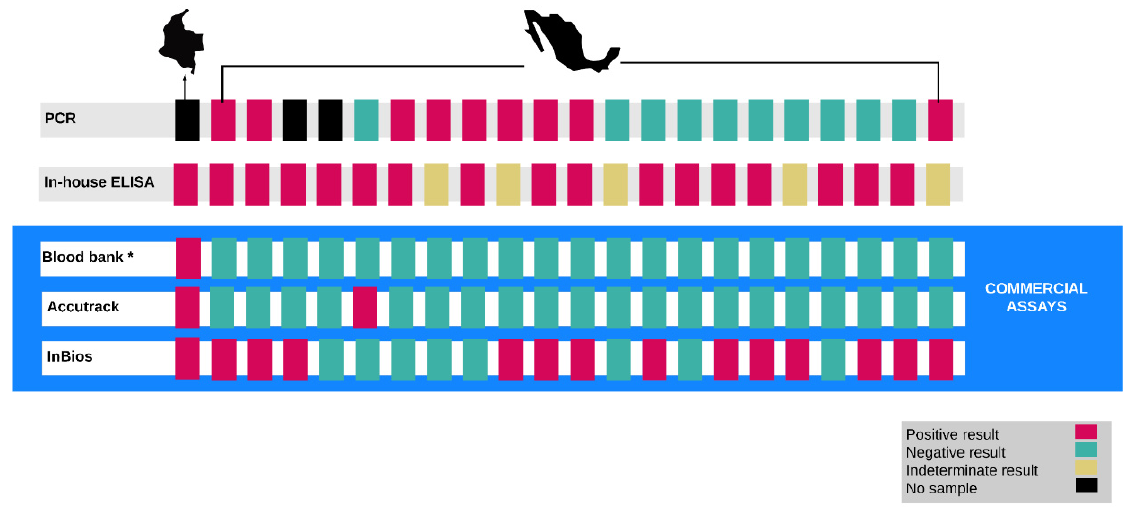
Figure 1. States of origin of patients with positive and negative results from the CD screening test (“in-house” ELISA) used at HGM.